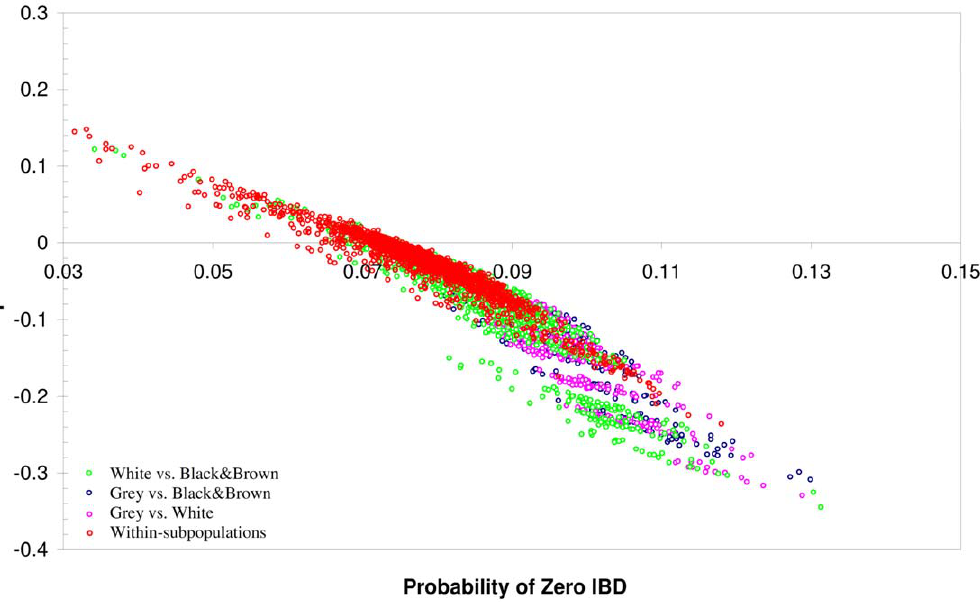
Figure 3. Population sub-structure in 99 SheepHapMap samples based on SNP analyses. Robust estimator of pairwise kinship coefficient ( W SNP ) as a tool for population substructure discovery. Within-population comparisons are shown in red. Other coloured dots represent comparison of individuals from distinct subpopulations.